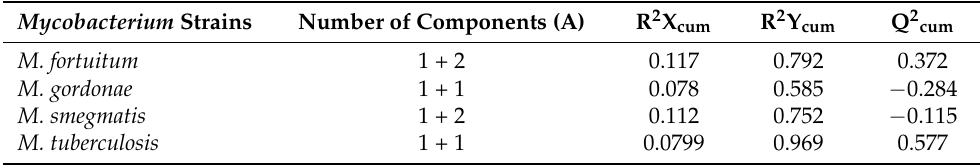
Table 1. OPLS–DA model statistics for the four Mycobacterium species.